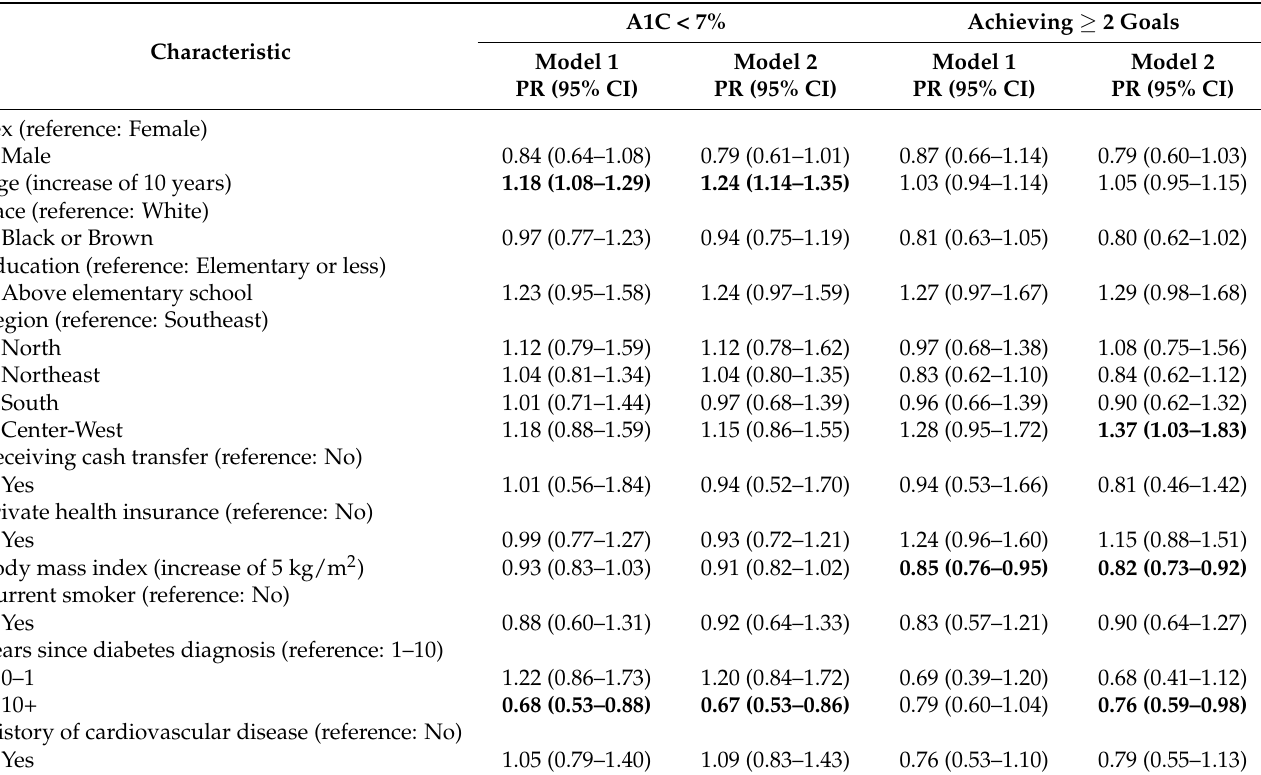
Table 3. Factors associated with glycemic control (glycated hemoglobin < 7%) and attainment of glycemic, blood pressure and cholesterol (ABC) control (attainment of two or more goals) among those with self-reported diabetes: Laboratory subsample, National Health Survey—Brazil,